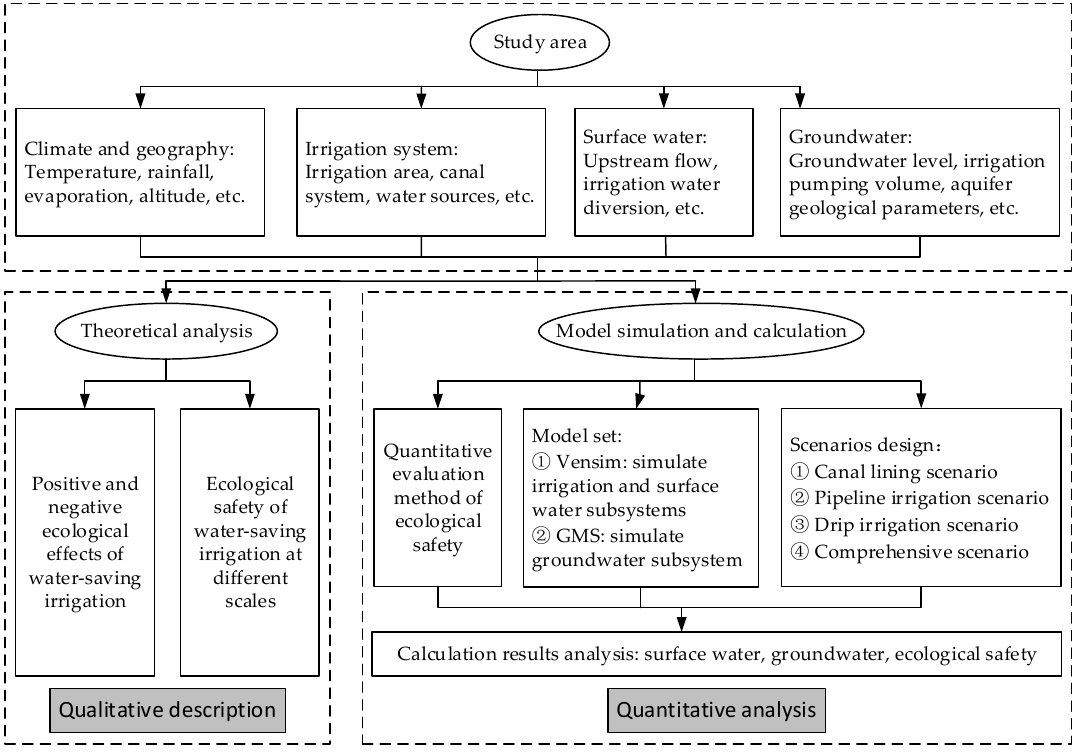
Figure 1. Flow chart of the methodology.